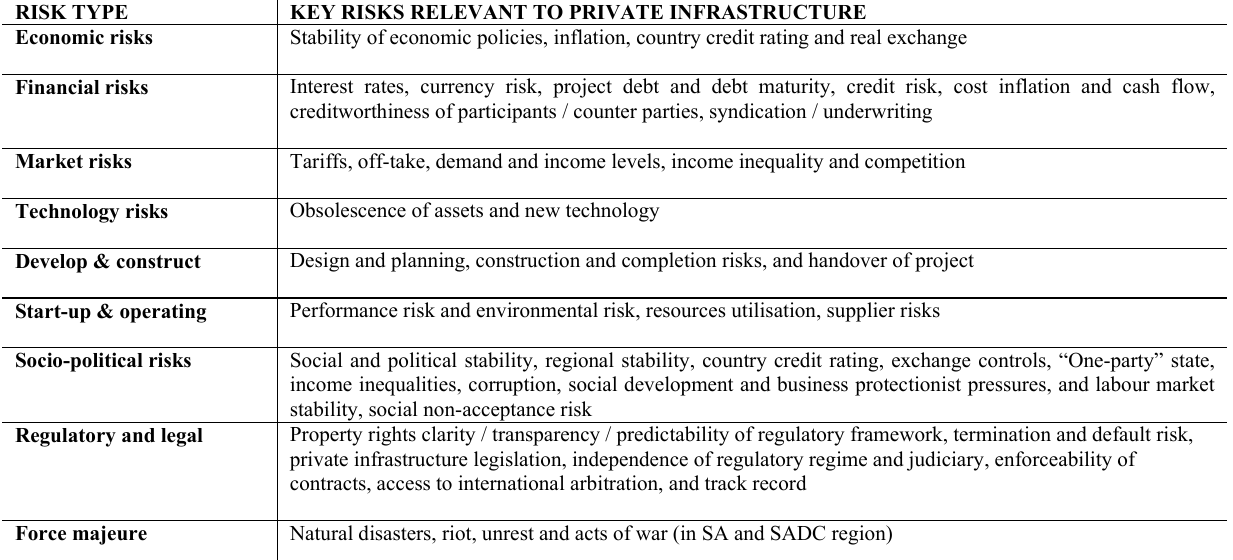
Table 1: Key risks in private infrastructure RISK TYPE KEY RISKS RELEVANT TO PRIVATE